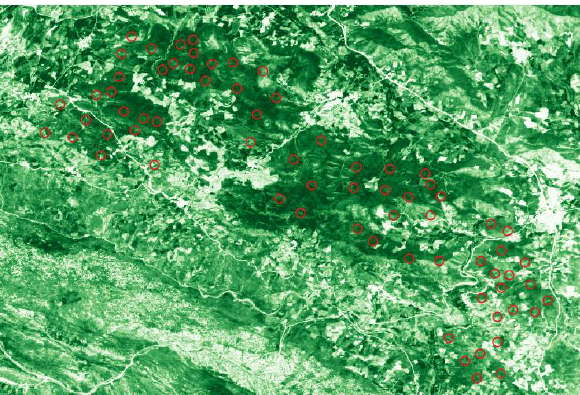
Figure 4. Estimated AGB using best predictor from RFR algorithm, where dark green indicates maximum AGB (65.63 t hec -1 ) and light green indicates lowest value (37.45 t hec -1 ). Red circles point to the measuring